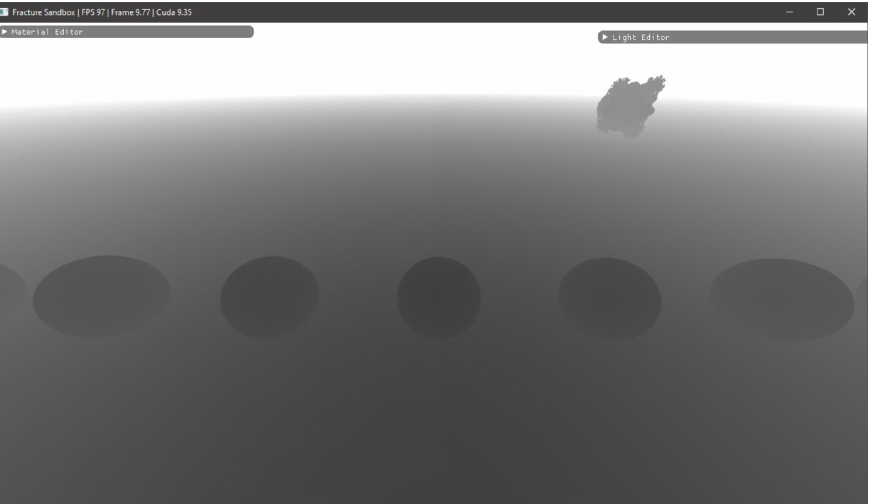
Figure 9. View 1: final, fully shaded render pass.